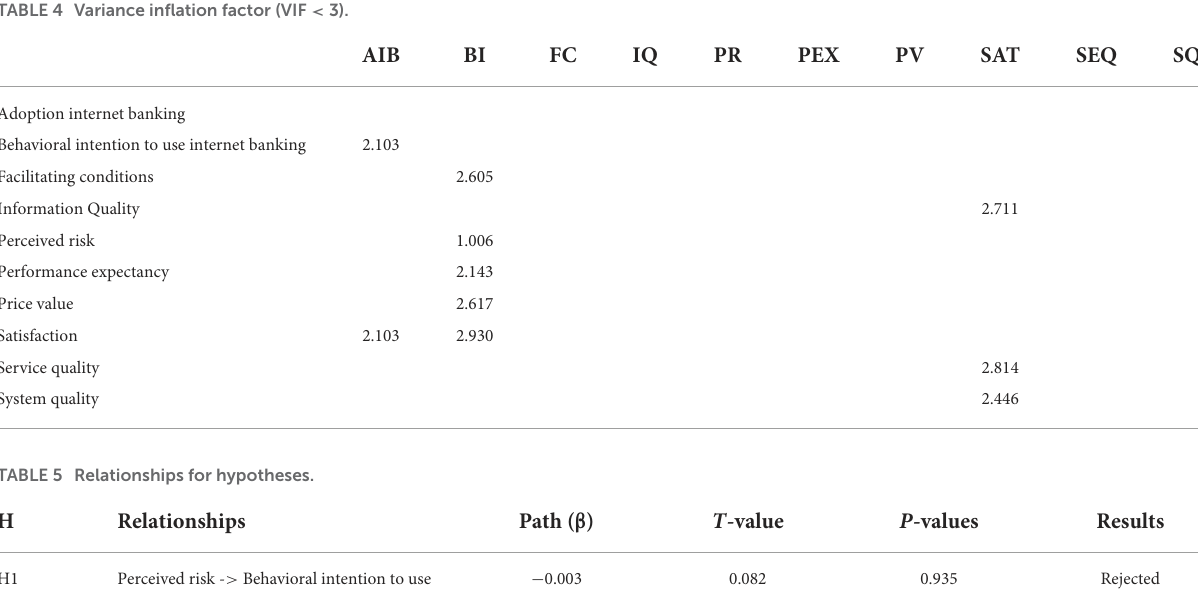
TABLE 4 Variance inflation factor (VIF < 3).